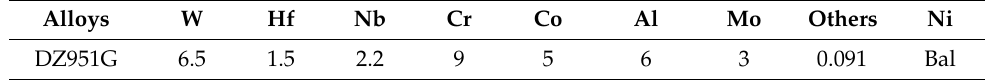
Table 1. Normal chemical composition of DZ951G superalloy. Alloys W Hf Nb Cr Co Al Mo Others